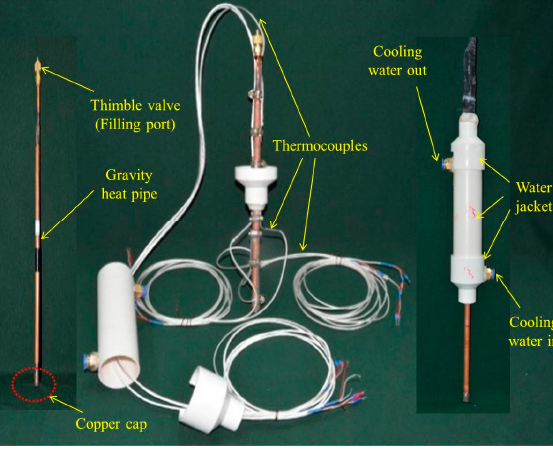
Figure 2. Schematic diagram of experimental apparatus.